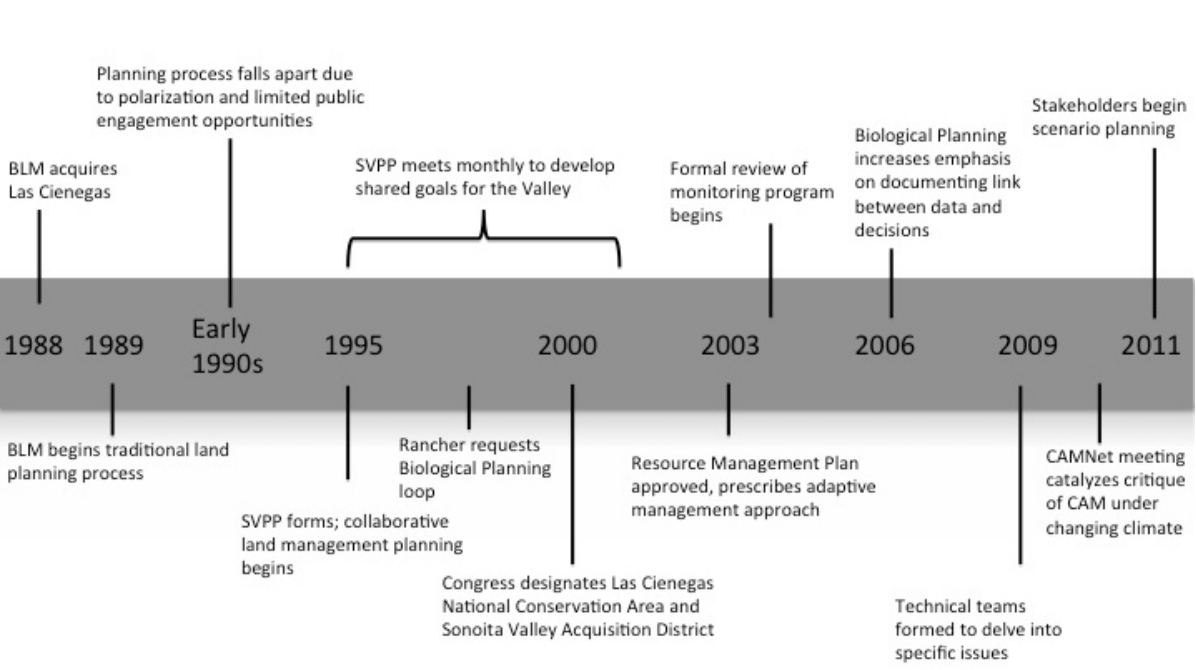
Fig. 2 . A timeline of important milestones and the evolution of collaborative adaptive management (CAM) at Las Cienegas National Conservation Area. BLM = Bureau of Land Management; SVPP = Sonoita Valley Planning Partnership; CAMNet = Collaborative Adaptive Management